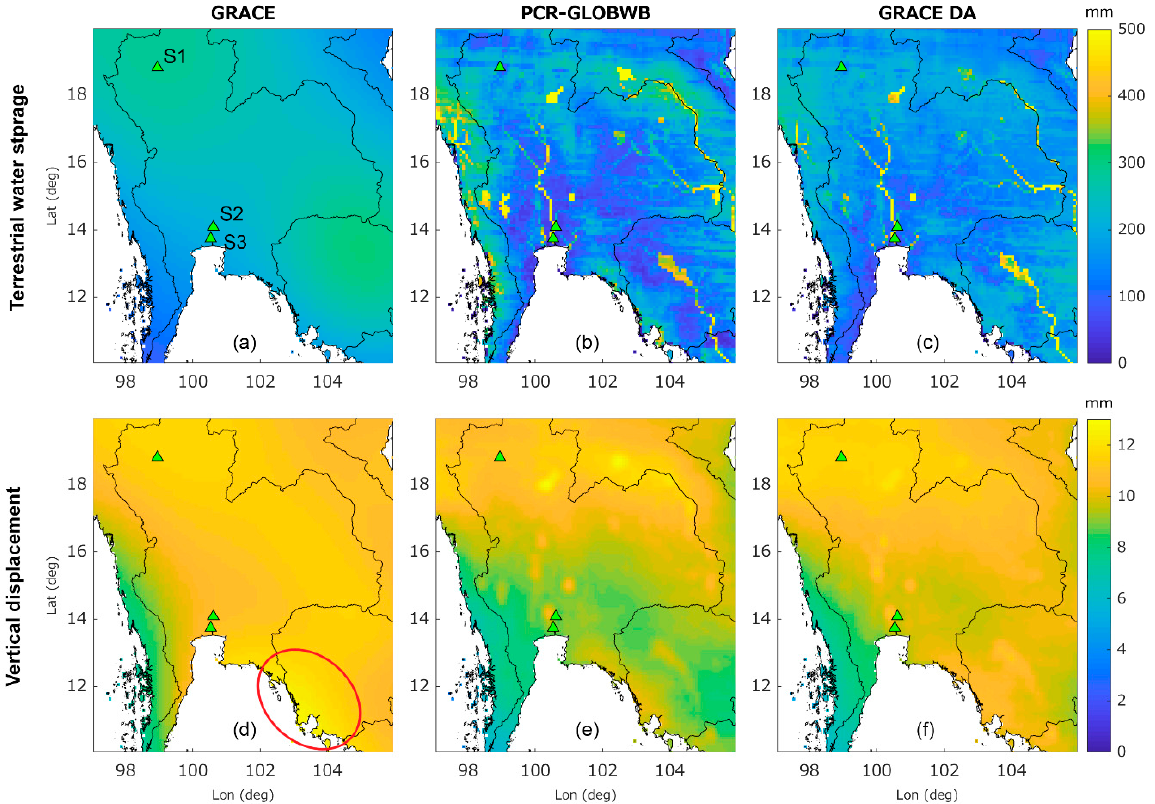
Figure 3. Annual amplitude estimates of the terrestrial water storage variations ( ∆ TWS) (first row; a – c ) and vertical displacement variations ( ∆ r) (second row; d – e ) derived from the GRACE (first column; a , d ), PCRaster Global Water Balance (PCR-GLOBWB) model (second column; b , e ), and GRACE DA (data assimilation) estimates (third column; c , f ). The evaluation sites (S1–S3) are shown as green triangles (see the site’s name in ( a )). The red oval in ( d ) illustrates the location where the atmospheric and oceanic loadings are prominent.